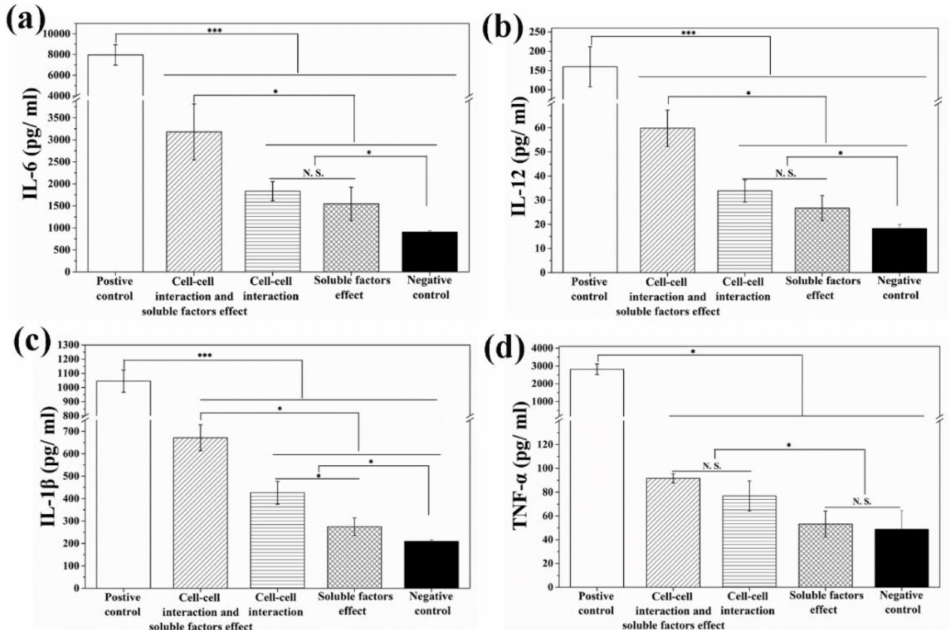
Figure 7. Secretion level of cytokines IL-6 ( a ), IL-12 ( b ), IL-1 β ( c ) and TNF- α ( d ) by dendritic cells (DCs) after co-culture of immature DCs with photothermally ablated tumor cells under different co-culture models. Data are presented as mean ± standard deviation, n = 3. No significant difference: N.S.; significant difference: * p < 0.05; *** p <